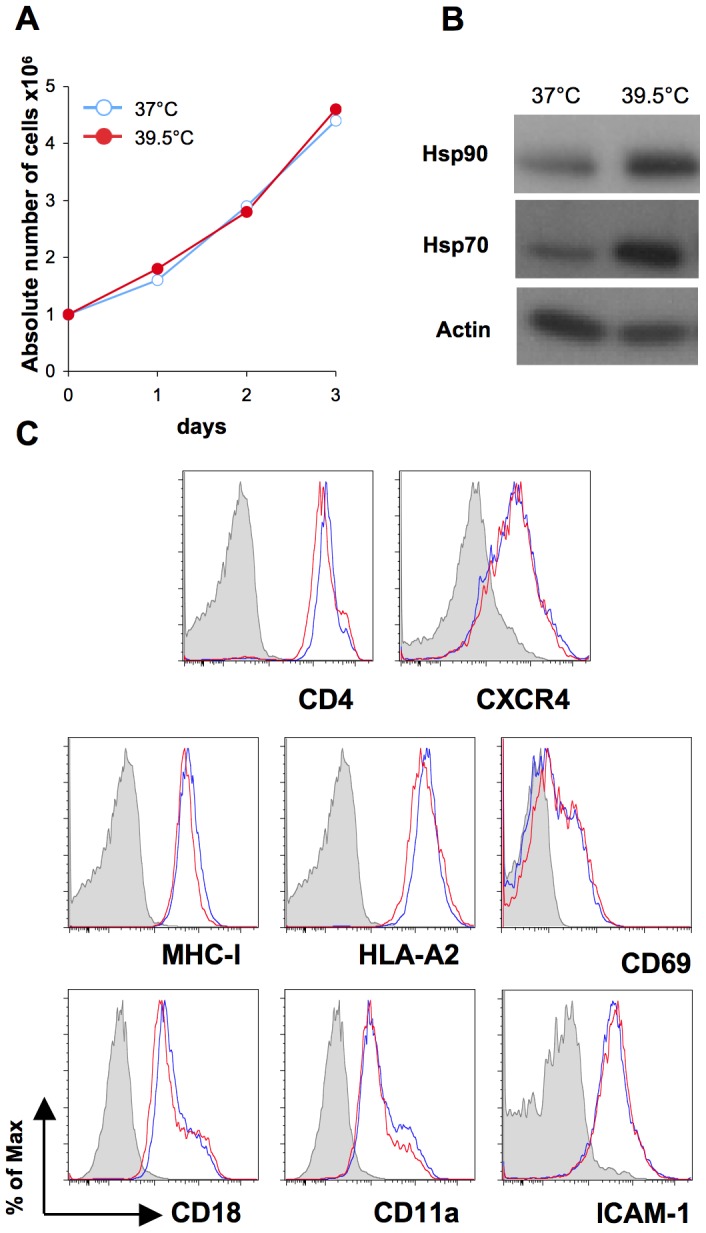
Cell growth and expression of Hsp70, Hsp90, and surface molecules in hyperthermic T cells.A: Primary CD4+ T cells were grown at 37°C or 39.5°C for 3 days. Cell growth was assessed every day by direct counting of living cells (Trypan blue exclusion). B: Primary CD4+ T cells were incubated 8 hours at 37°C or 39.5°C. Cell lysates were collected and probed by Western Blot for Hsp90, Hsp70 and Actin. C: Primary CD4+ T cells were grown at 37°C (blue line) or 39.5°C (red line) for 3 days. Cells were stained for the indicated surface markers and fixed in PFA. Isotype-matched monoclonal antibodies were used as negative controls (grey line).